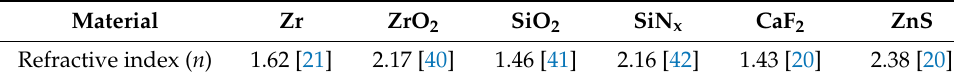
Table 1. Refractive indexes of multilayer films at 550 nm.